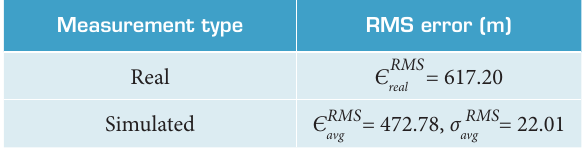
table 2. IMMPDAF RMS error